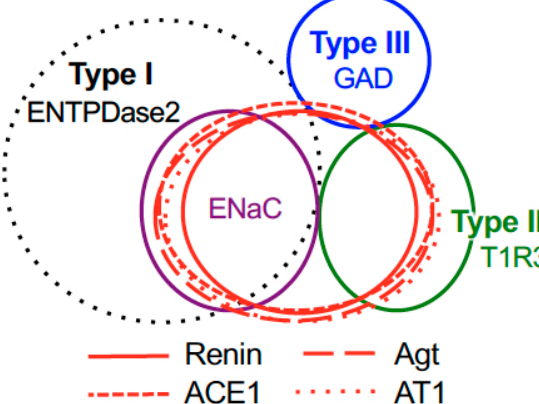
Agt: angiotensinogen; ENTPDase2: ecto-nucleoside triphosphate diphosphohydrolase-2; GAD: glutamate decarboxylase; T1R3: taste receptor type 1 member 3. The number of protein1 + protein2 doubly labeled cell/number of protein2 positive cell, and n = number of taste buds examined are shown in parentheses.